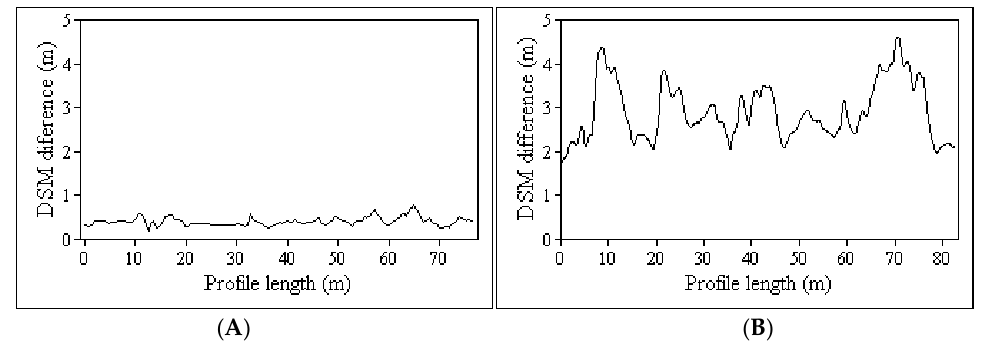
Figure 5. Road profile ( A ) and calamity profile ( B ) comparison between the of UAS DSM and UAS/ALS DTM maps.